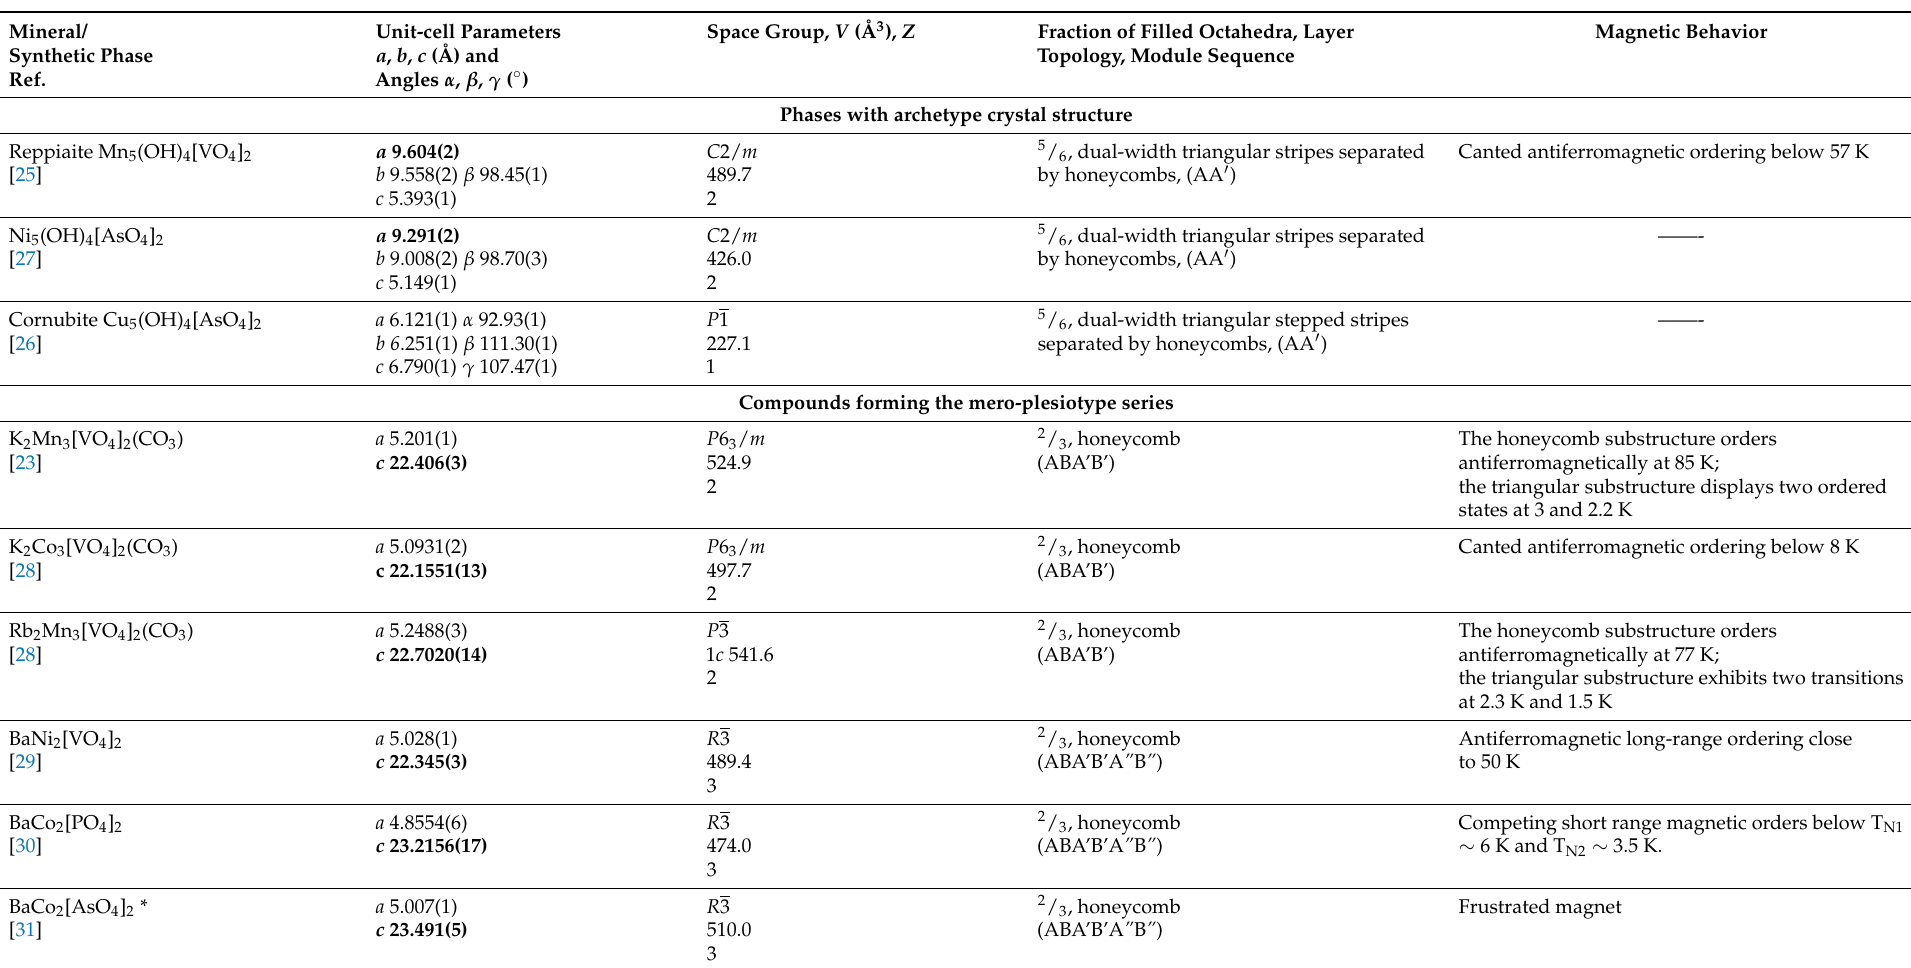
Table 1. Mero-plesiotype series of vanadates, arsenates, and phosphates of the first-row transition